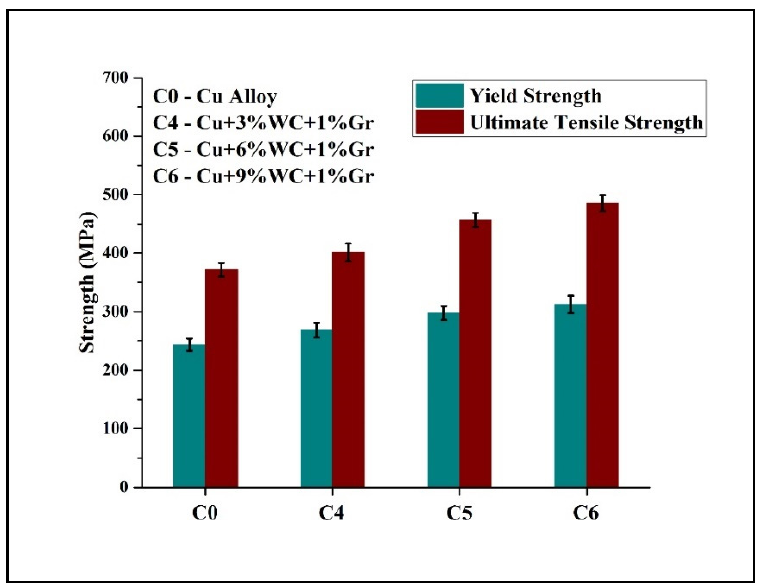
Figure 14. Variation of yield strength and ultimate tensile strength of Cu alloy and Cu-(3, 6, 9) wt.% WC-Gr hybrid composites.